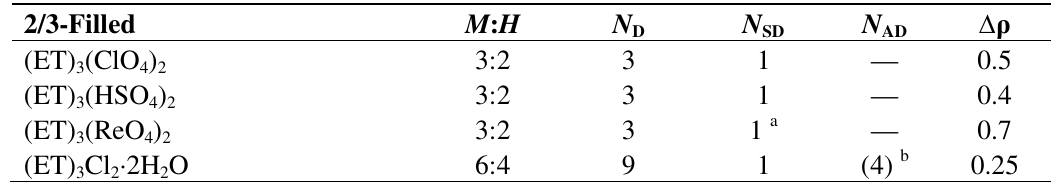
Table 2. The number of all charge distributions, N the allowed distribution, N , at low temperature. The CO state (metal) is defined as AD N = 1 ( N = N ). Charge fluctuation occurs when the condition of 1 < N SD SD D denotes the difference in the molecular charge between the ionic and neutral-like molecules at low